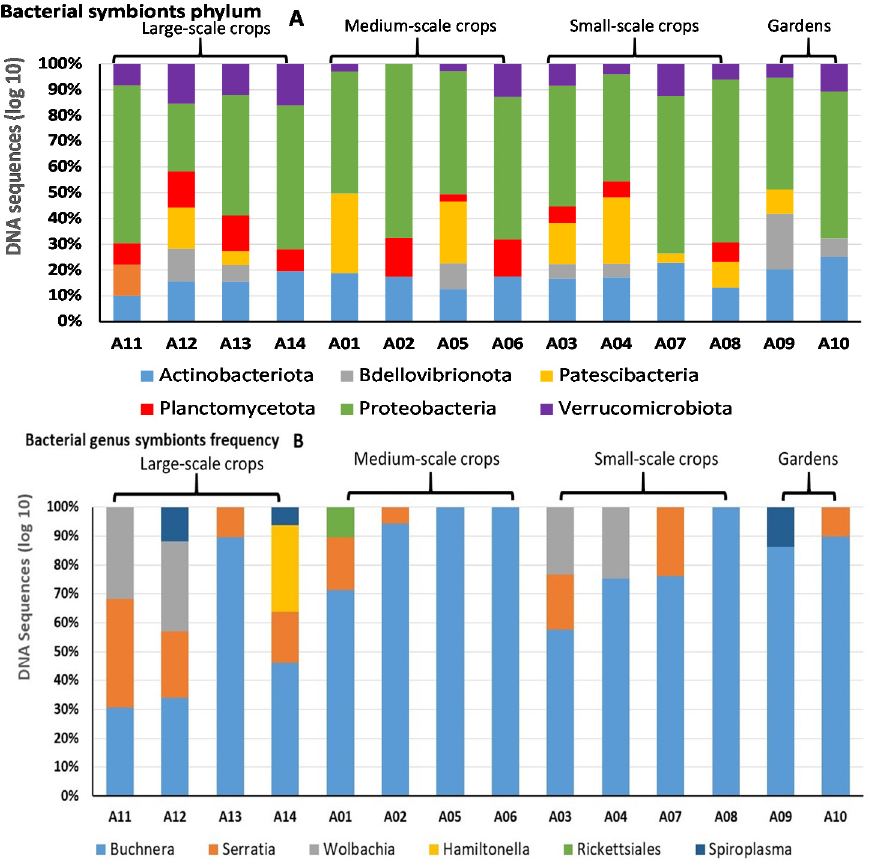
Figure 1. Dominant bacterial phylum variations by sites according to the DNA sequences frequency ( A ) and endosymbiontic bacterial genera variations by sites according to the DNA sequences fre- quency ( B ).